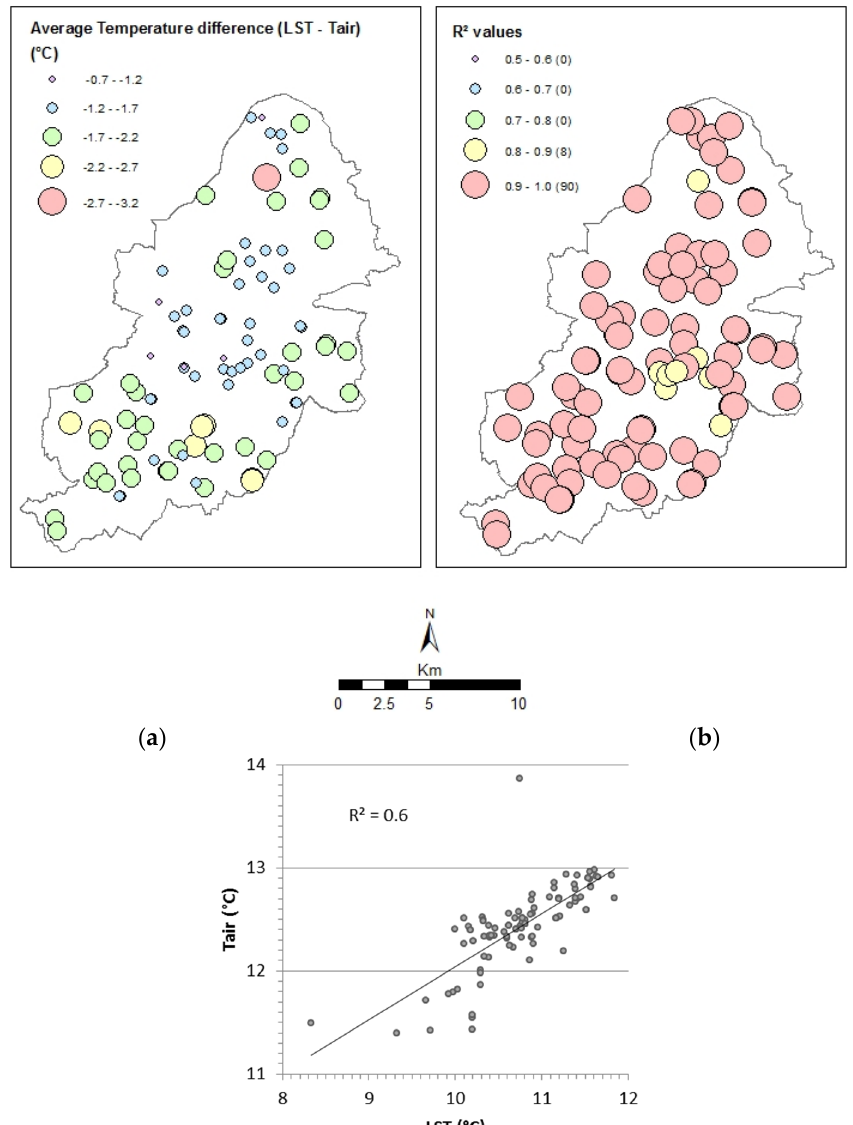
Figure 7. LST and T air night-time comparison at 1:30. ( a ) LST—T air difference (MODIS—BUCL); ( b ) R 2 values at sensors and weather stations location; ( c ) R 2 values for city scale (all sensors and weather stations). Table 6. Temperature difference (LST—T air ) at 1:30 and Land use [37].